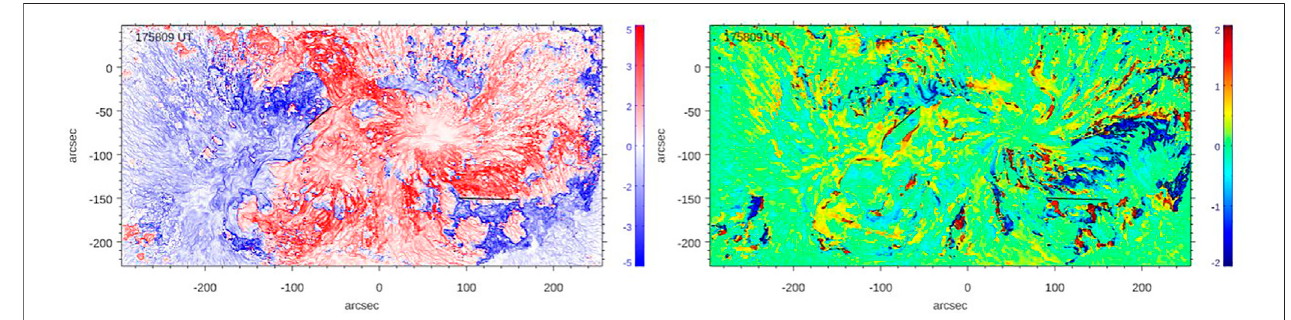
FIGURE 2 | Distribution of log Q (left) and T W parameters on the photosphere immediately before the fl are onset. The two line segments in the maps mark strong Q-lanes situated above the photospheric polarity inversion line. The T W image is scaled between − 2 < T W < 2, while contours outline areas with | T W | >